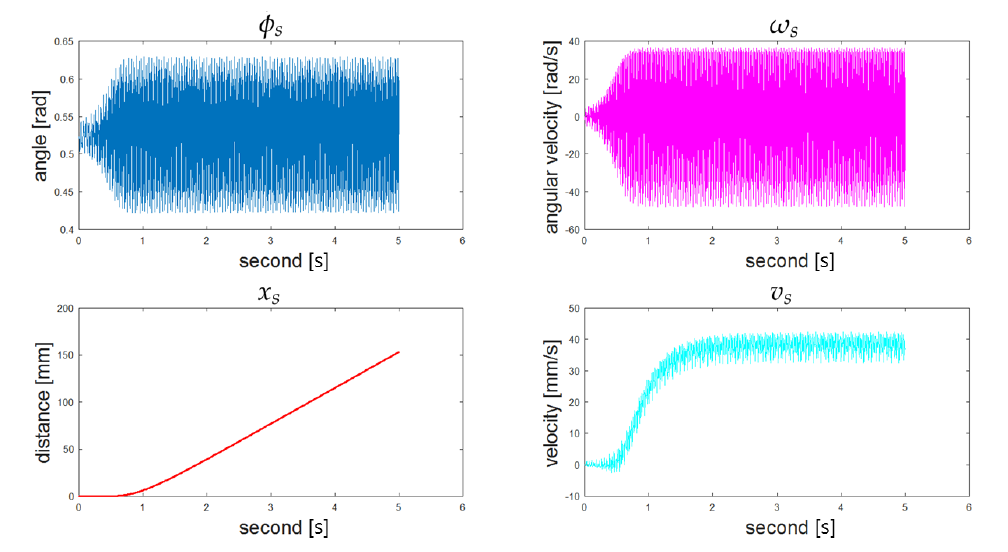
Figure 7. Simulation result plots of φ s , ω s , x s , v s under the given conditions Ω = 160 rev/s and µ ∗ =